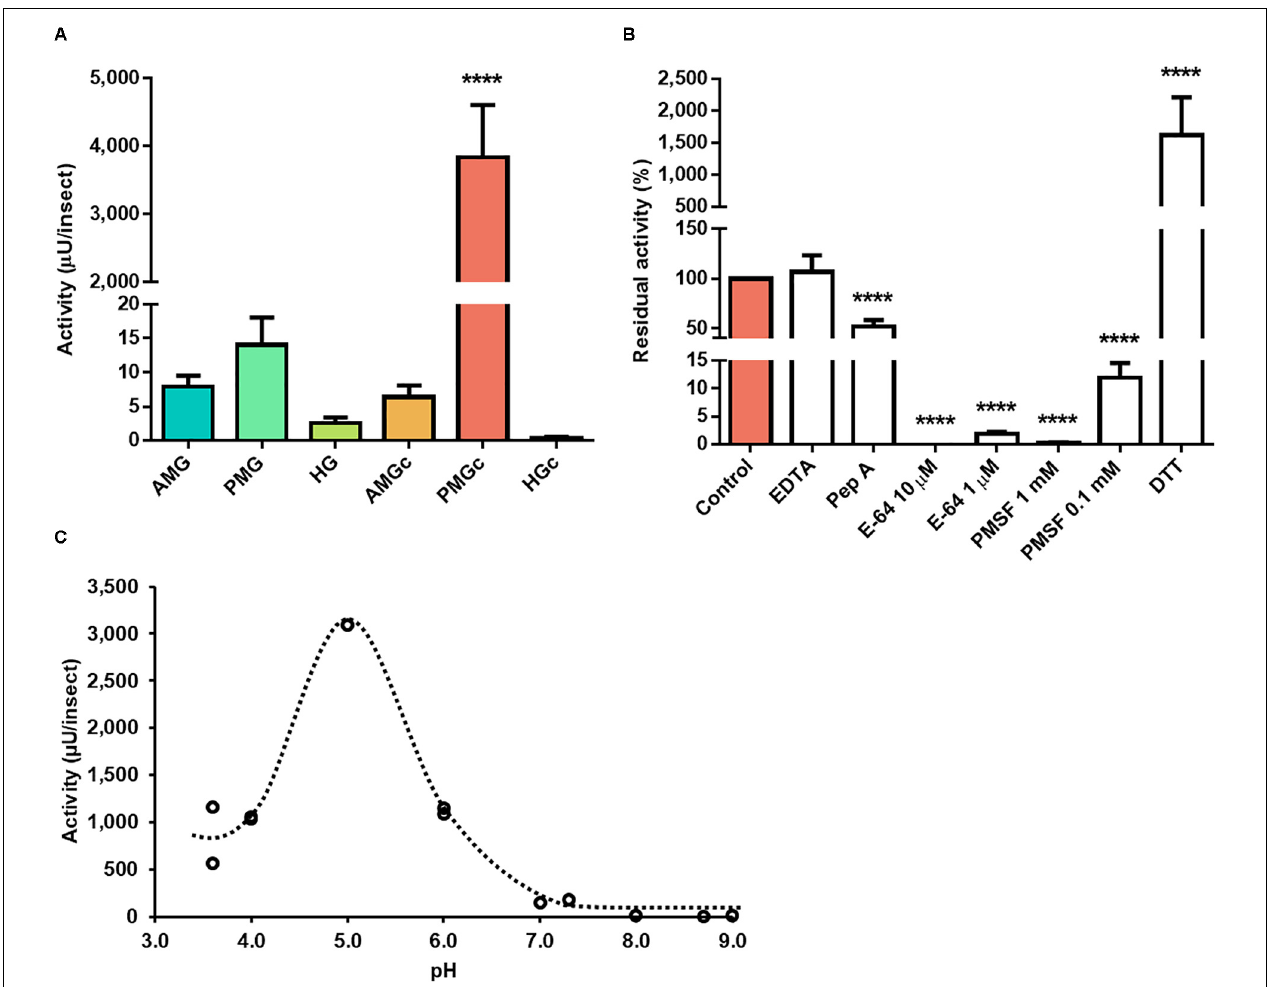
FIGURE 1 | Compartmentalization and characterization of cathepsin L activity in the digestive tract compartments of male adult Rhodnius prolixus . (A) Comparison of protease activity between homogenates of the anterior midgut (AMG), posterior midgut (PMG), and hindgut (HG) and their respective luminal contents, assayed in 0.2 M citrate-phosphate pH 5.5. (B) Effects of the protease inhibitors EDTA (1 mM), pepstatin A (1 µ M), E-64 (10 and 1 µ M), PMSF (1 mM and 0.1 mM), and the activator DTT (10 mM) on the proteolytic activity of the PMG contents, assayed in 0.2 M citrate-phosphate pH 5.5. (C) Effects of the pH variation on the proteolytic activity of the posterior midgut contents using the buffers glycine-HCl, pH 3.6; sodium acetate, pH 3.6 and 4.0; citrate-phosphate, pH 4.0, 5.0, and 6.0; MES, pH 6.0 and 7.0; EPPS, pH 7.3, 8.0, and 8.7; and glycine-NaOH, pH 9.0. Bars and markers are means of at least three biological replicates with the standard error of the mean. Asterisks denote statistically significant differences, where **** p ≤